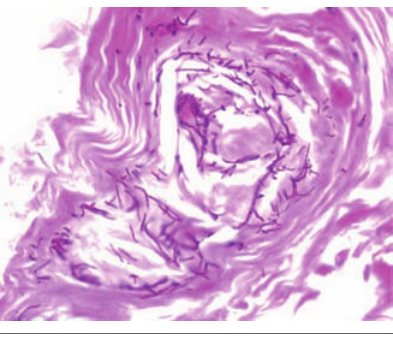
Figure 2. Photomicrograph showing fungal hyphae in the keratin layer of the epider- mis, highlighted by periodic acid Schiff staining (magenta colour) (Periodic acid Schiff x 400).